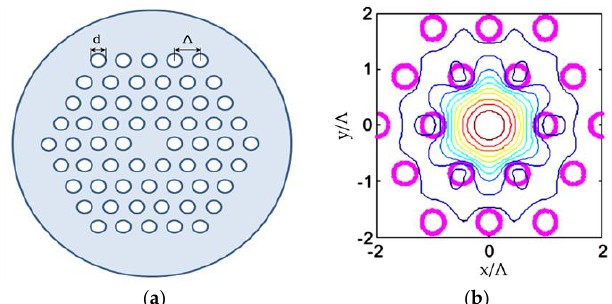
Figure 5. ( a ) Schematic cross-section of the PCF with 4 air-hole rings (60 air-holes). The d/Λ is the air-hole size, and the background material is silica. ( b ) Intensity profile of the fundamental leaky mode for a PCF having 2 air-hole rings (18 air-holes), d/ Λ = 0.4 and λ / Λ = 0.5.